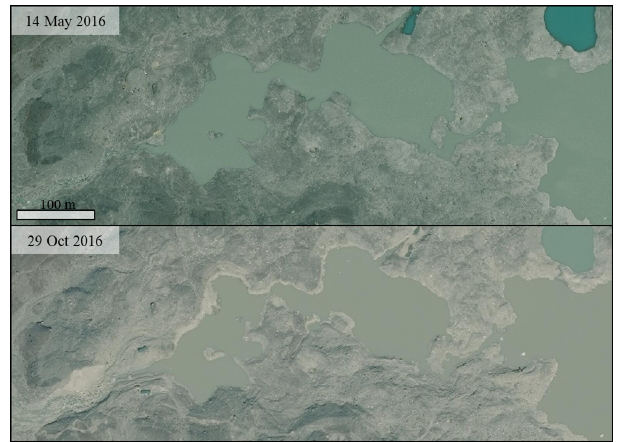
Figure 3. WorldView-2 (0.5m; DigitalGlobe, Inc.) imagery of the lake before (14 May 2016) and after (29 October 2016) the lake lowering project, showing a ring of discoloration around the outlet ponds but not the main